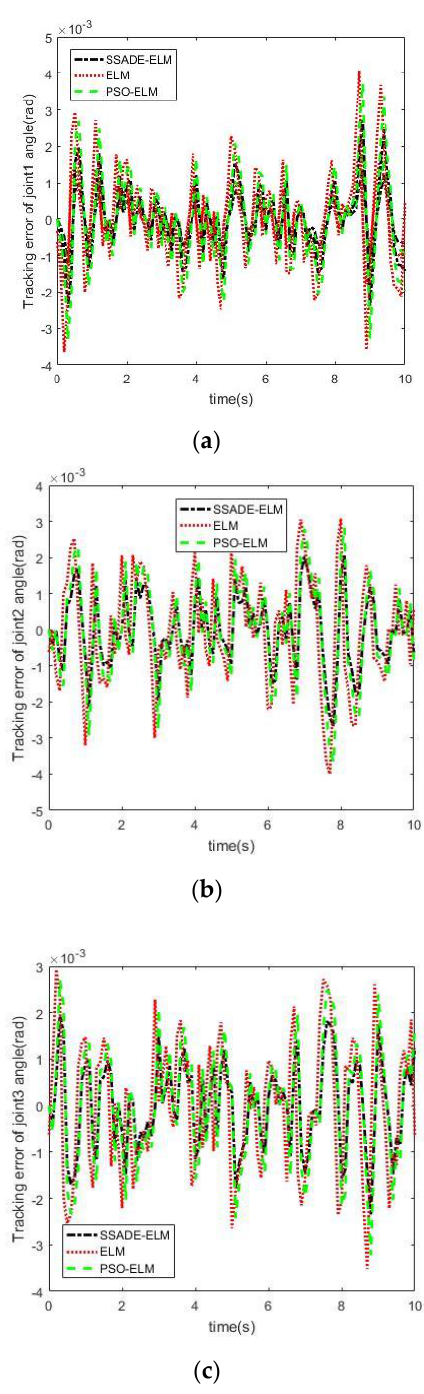
( f ) Figure 10. Space robot attitude parameters by experiment. ( a ) The base angle; ( b ) The base angular velocity; ( c ) The joints angle via Variable Forgetting Factor Recursive Least Squares